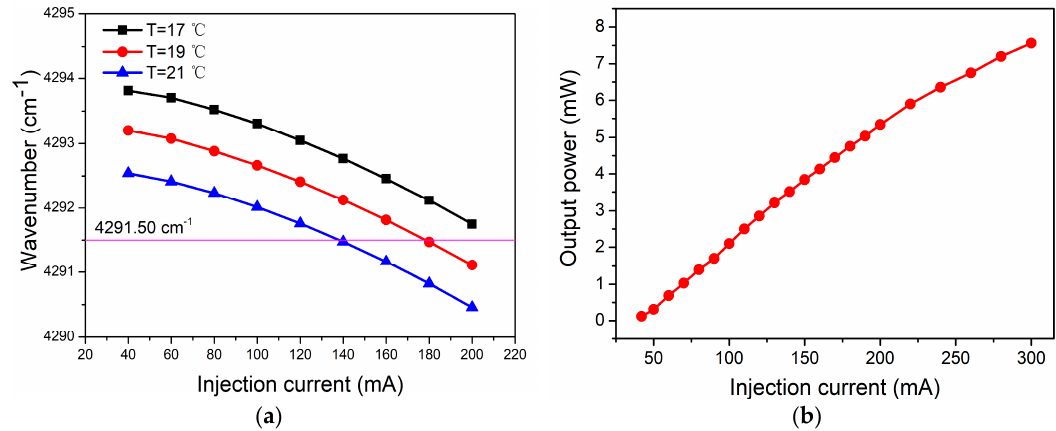
Figure 2. ( a ) The wavenumber of a continuous wave (CW), distributed feedback (DFB), 2.3 μ m laser as a function of injection current at different temperatures. ( b ) The output power of a CW, DFB, 2.3 μ m laser as a function of injection current.